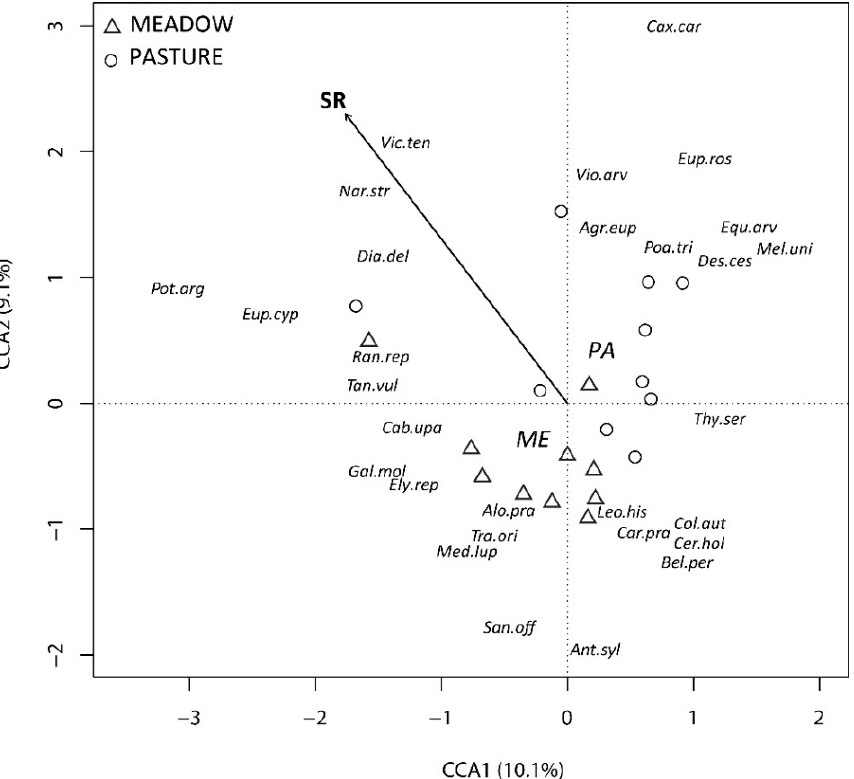
Figure 3. Canonical correspondence analysis (CCA) ordination triplot showing significant variables, sampling sites, and selected species. Only 20% of species best fitted by the ordination space are displayed. Total inertia 1.66; for percentage of explained variance see axes titles. ME, MEADOW; PA, PASTURE; Agr eup , Agrimonia eupatoria ; Mel uni , Melica uniflora ; Vio arv , Viola arvensis ; Equ arv , Equisetum arvense ; Thy ser , Thymus serpyllum ; Eup off , Euphrasia rostkoviana ; Poa tri , Poa trivialis ;